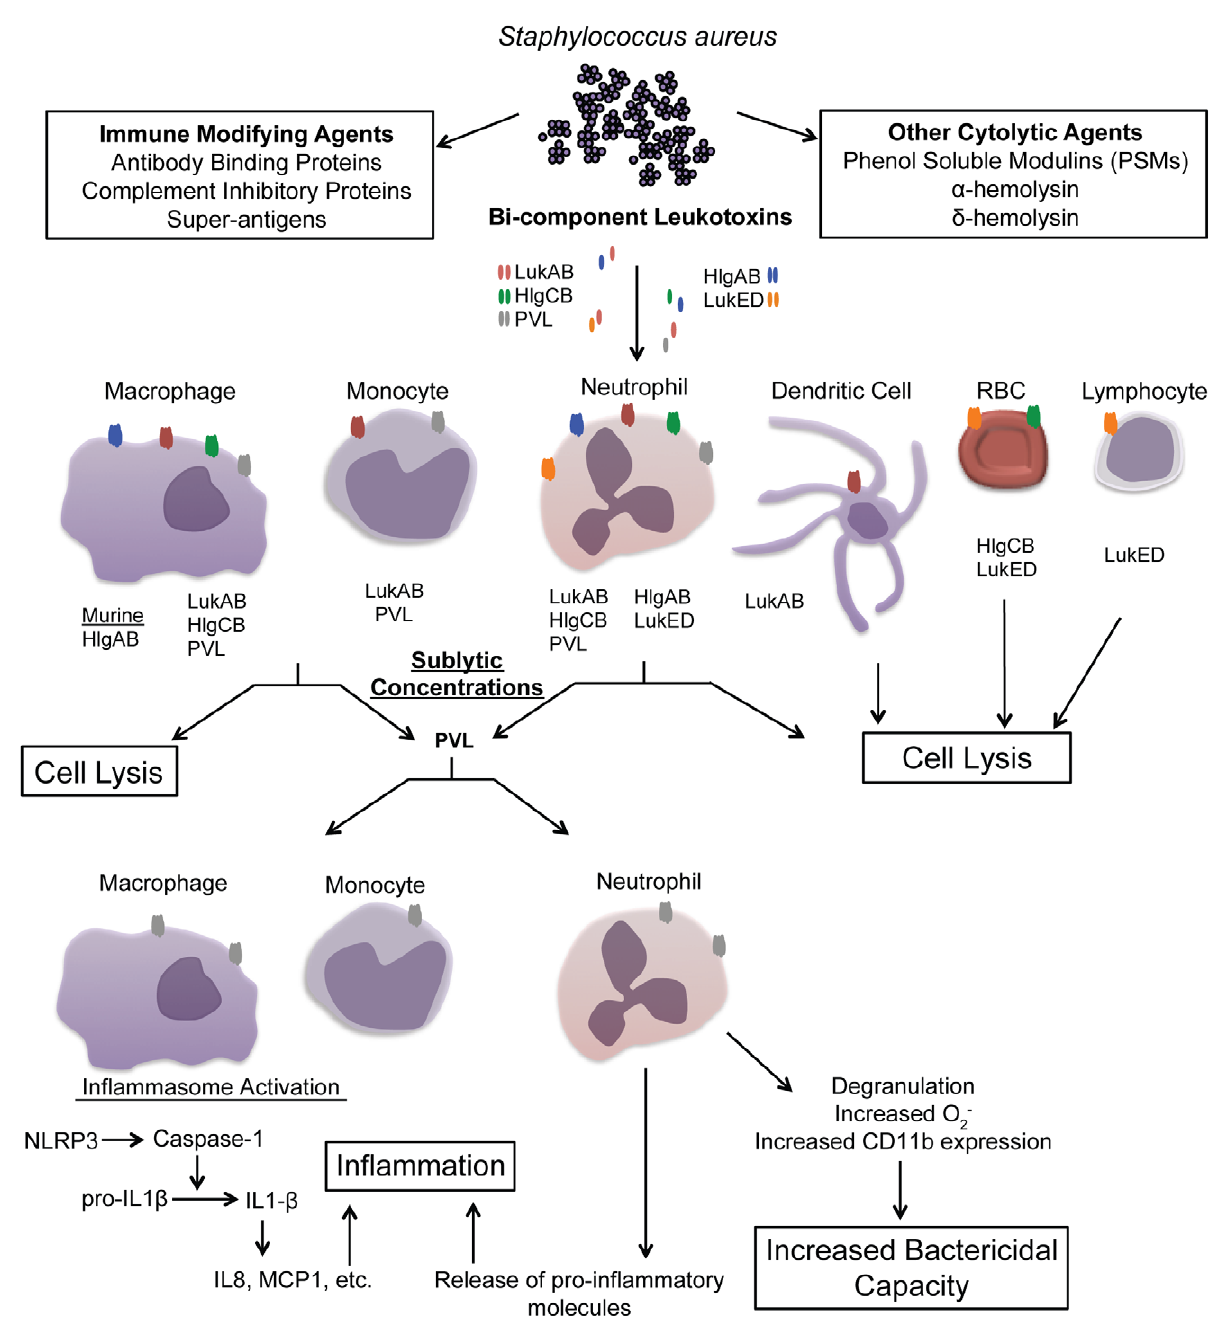
Figure 1. Overview of S.aureus leukotoxin action on host immune cells. The above schematic illustrates our current understanding of leukotoxin targeting and the functional consequences of toxin activity on specific immune cell types. Upon encountering host immune cells, S. aureus elaborates numerous molecules that facilitate escape from bacterial killing. The bi-component leukotoxins (LukAB, red; HlgCB, green; PVL, gray; HlgAB, purple; LukED, orange) are one class of lytic molecules that directly target and kill immune cells. The cells types currently known to be targets of each leukotoxin are shown. While the leukotoxins possess potent lytic capacity on their cellular targets, evidence also suggests a sublytic influence of PVL. The downstream effects of sublytic toxin activity, including inflammasome activation and enhanced bactericidal activity are